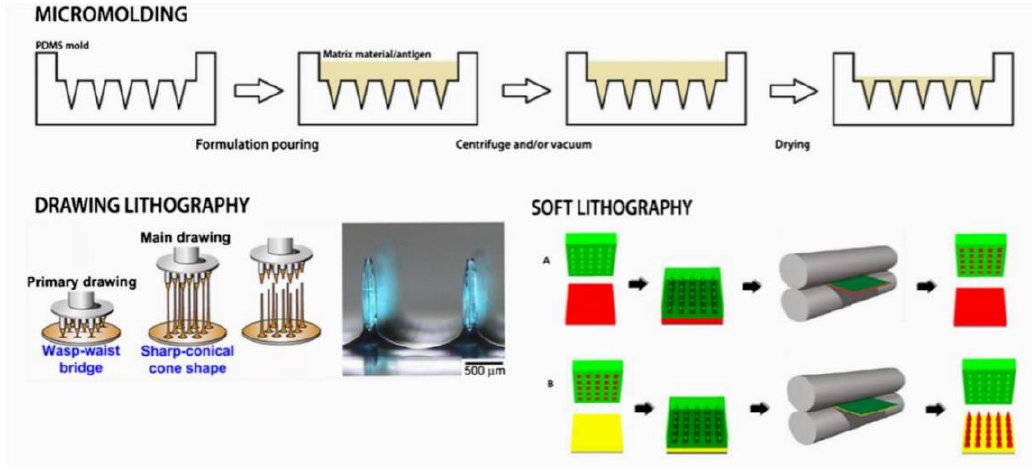
Figure2. Manufacturing methods of microneedle array patch (35)